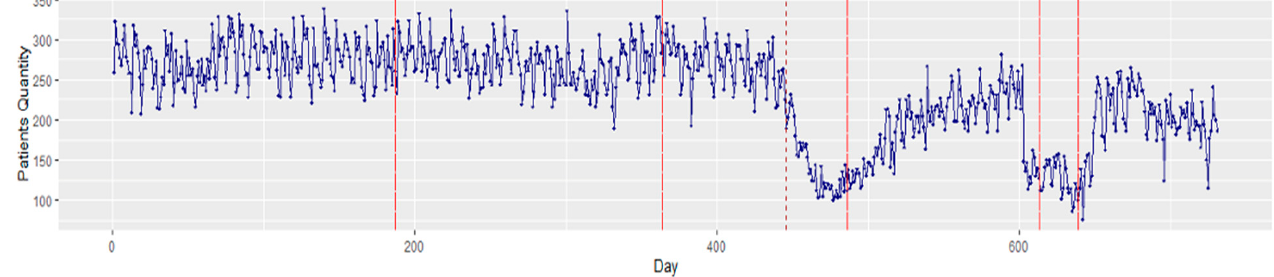
Figure 4. Time series plot of total ED patient visits for 2019–2020. The solid red lines depict the changepoints that occurred in the time series data, while the red dash line depicts the start of the COVID lockdown in Michigan, USA.